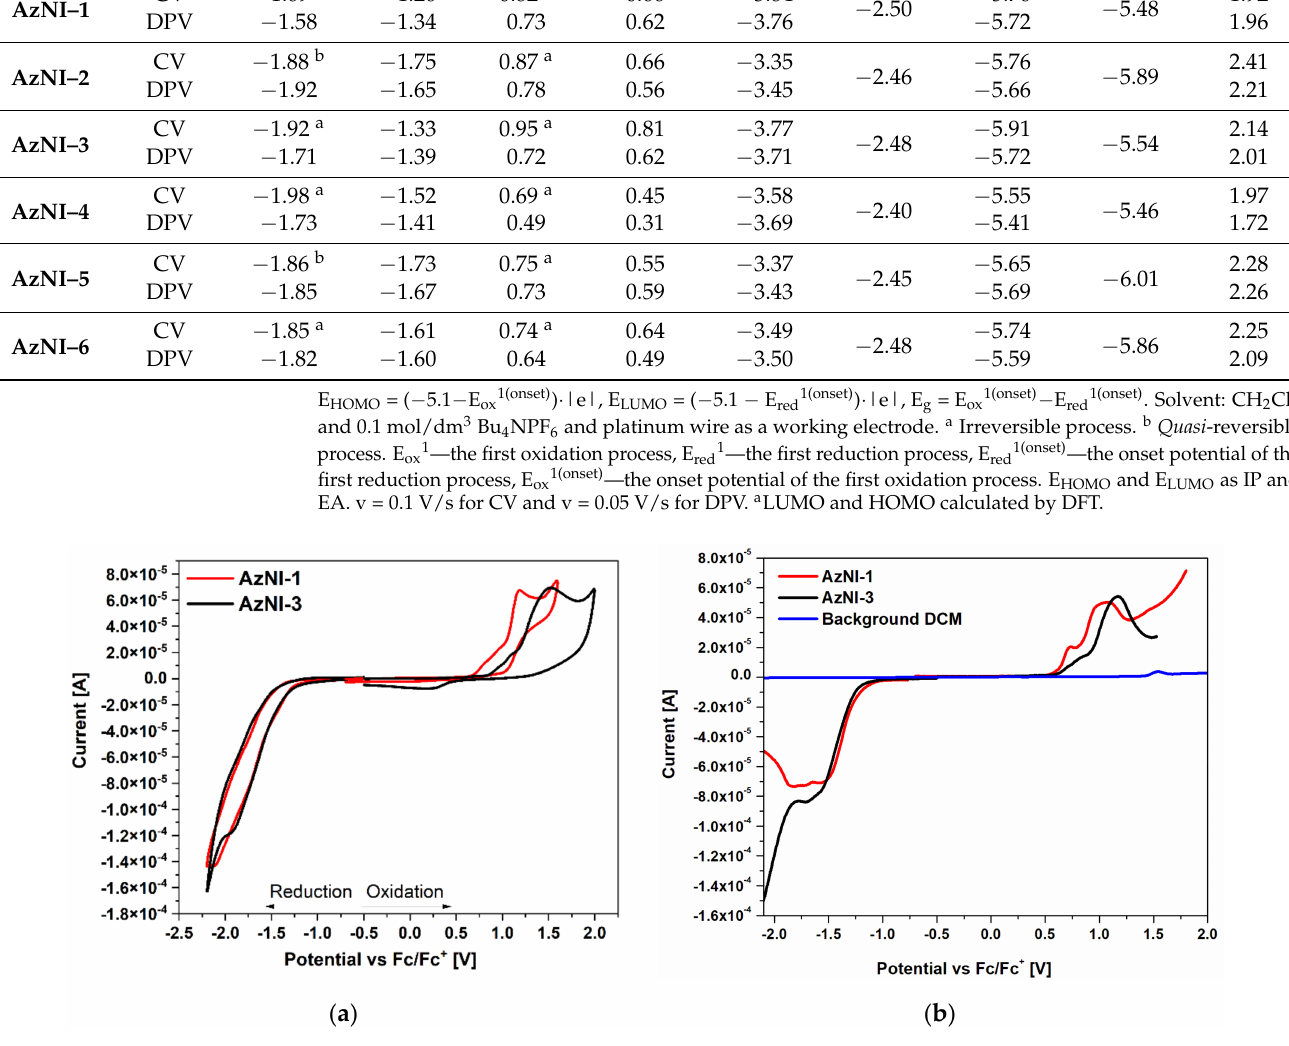
Figure 3. ( a ) Cyclic voltammetry (CV) and ( b ) differential pulse voltammetry (DPV) scans of AzNI-1 and AzNI-3 in positive and negative potential range (v = 0.1 V/s for CV and = 0.05 V/s for